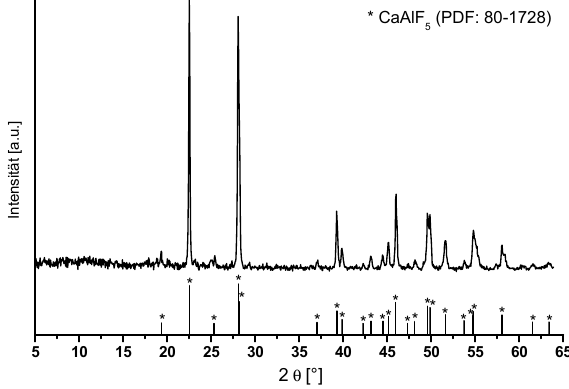
Figure 3. Comparison of powder X-ray patterns of CaAlF 5 xerogel in a closed crucible at 700 ° C for a two minute calcination time in a preheated oven at 700 ° C with crystalline CaAlF 5 phase (PDF: 80–1728).